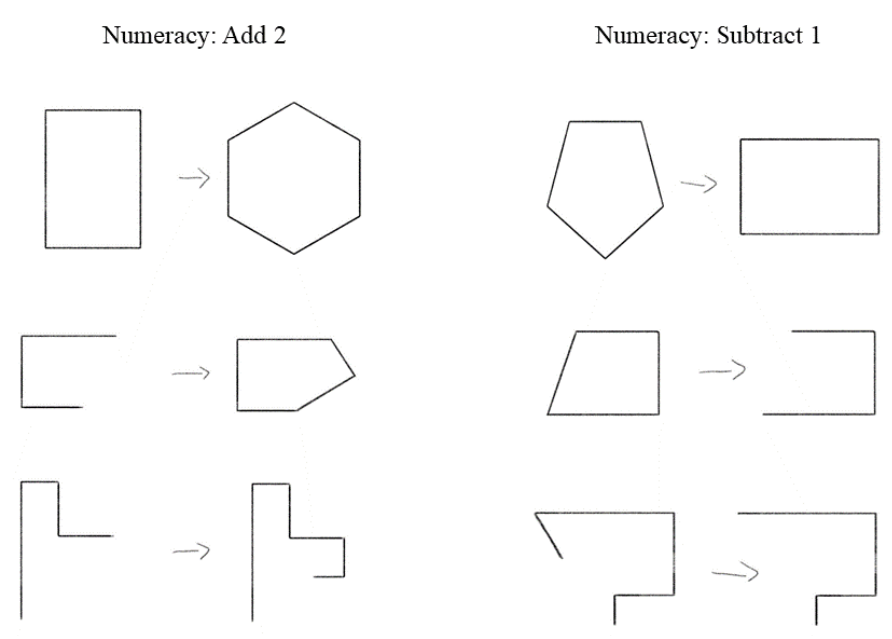
Figure 4. Numeracy A:B items. Note. Examples of the RSJT items used for the numeracy